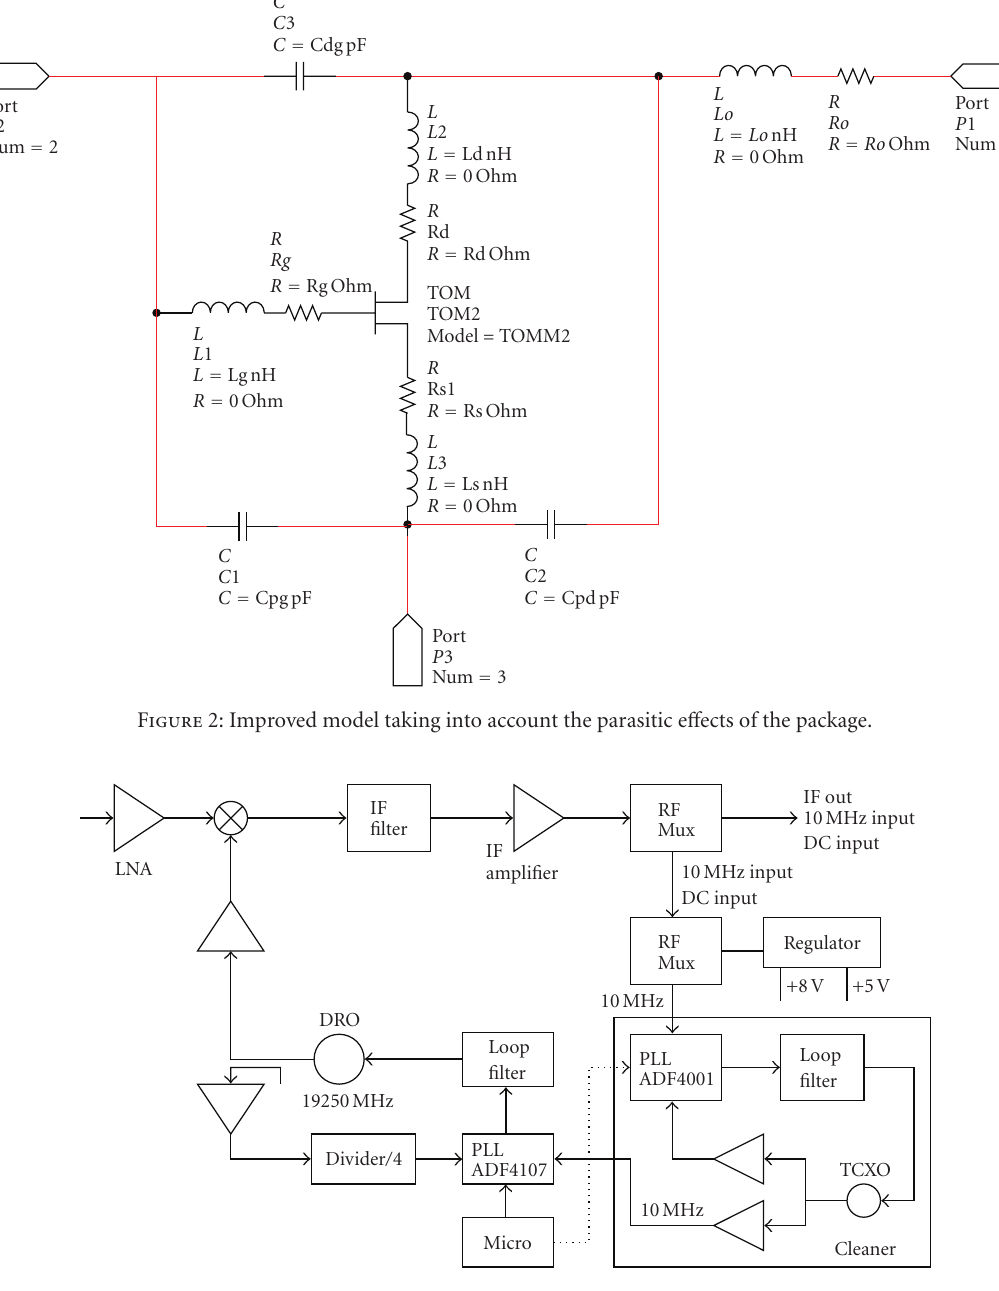
Figure 3: PLL block diagram.